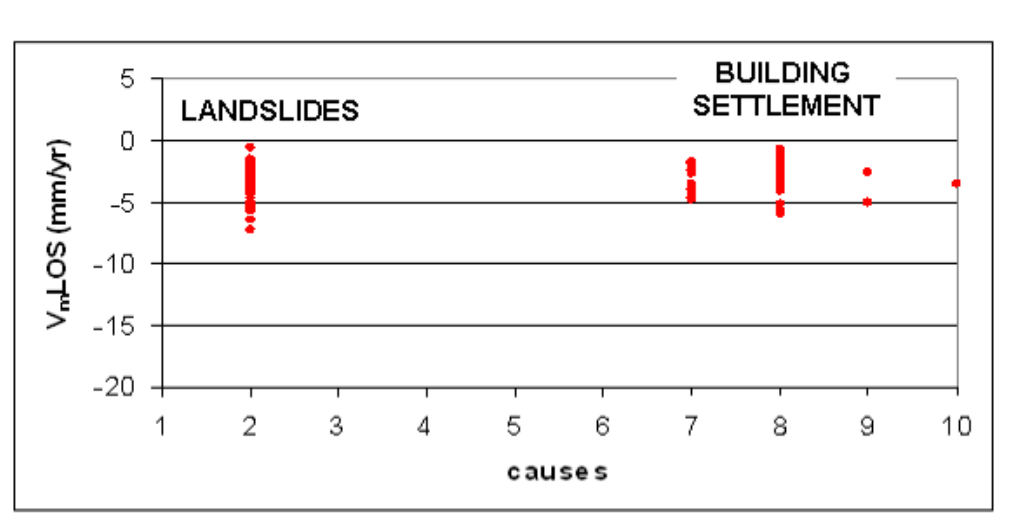
Figure 12. Comparison between the VLOS and the different typologies of movements in the Apennines (see Figure 8 for